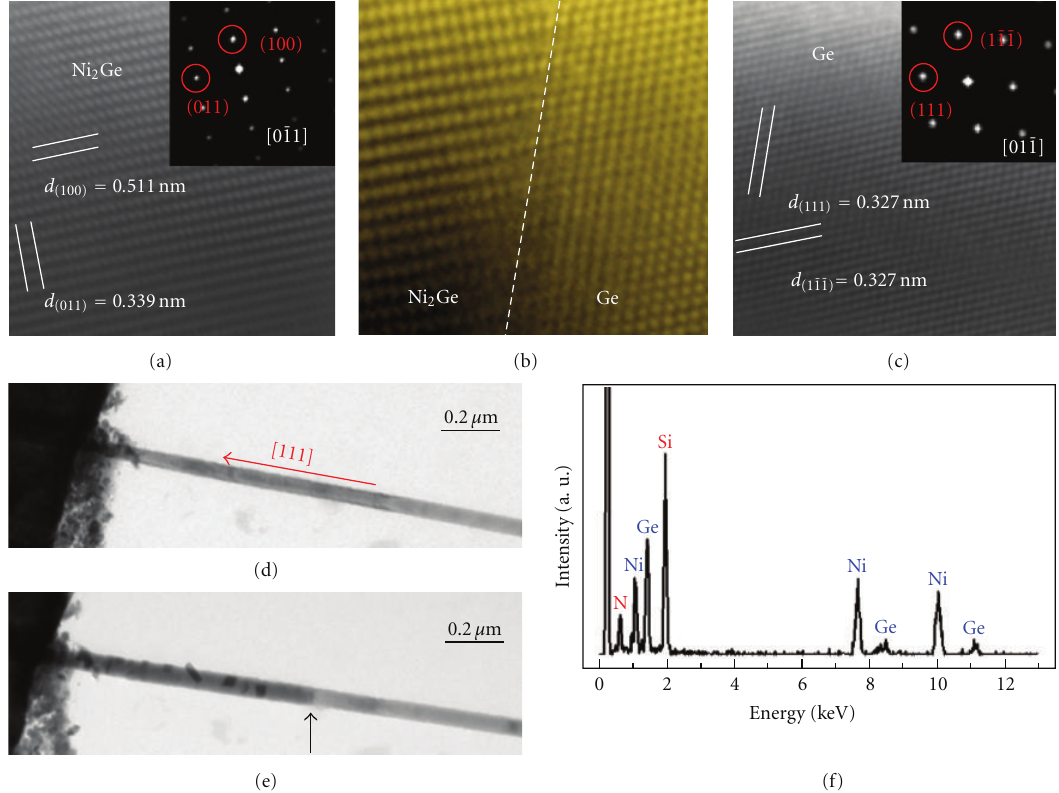
Figure 2: Epitaxial relationship at the Ni 2 Ge/Ge interface. (a) Lattice-resolved TEM image of the formed Ni 2 Ge nanowire. The inset shows the FFT pattern, confirming that the formed germanide phase is Ni 2 Ge. (b) TEM image of Ni 2 Ge/Ge heterostructure showing an atomically sharp interface. (c) Lattice-resolved TEM image of the unreacted Ge nanowire. The inset shows the FFT pattern. (d) Low magnification TEM image of the as-fabricated device with the Ni pad and the Ge nanowire. (e) Low magnification TEM image after annealing at 500 ◦ C. The arrow indicates the interface of the Ni 2 Ge/Ge nanowire. (f) EDS of Ni 2 Ge, showing a relative 2:1 concentration ratio of Ni and Ge atoms. Reproduced from